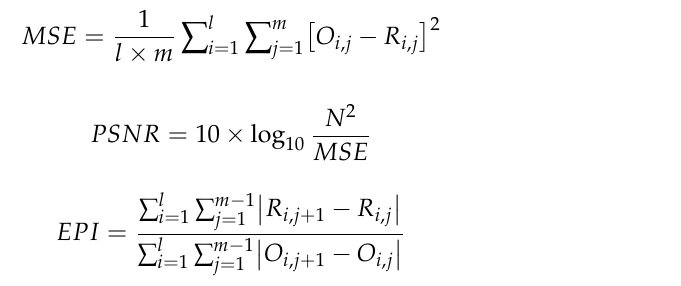
where O i,j and R i,j represent noise-free original and de-noised images of size l × m at location (i,j) respectively and N represent maximum possible gray-level value of a 8-bits per pixel. EPI values ranges from 0 to 1, higher value indicates better edge preservation.